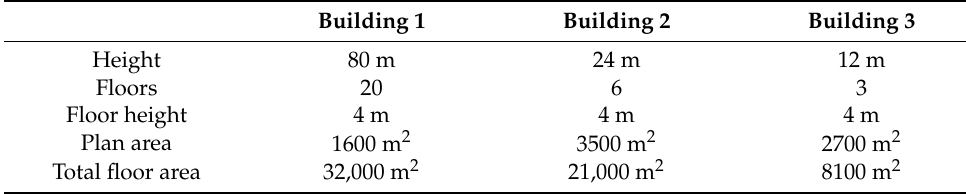
Table 2. Properties of the building